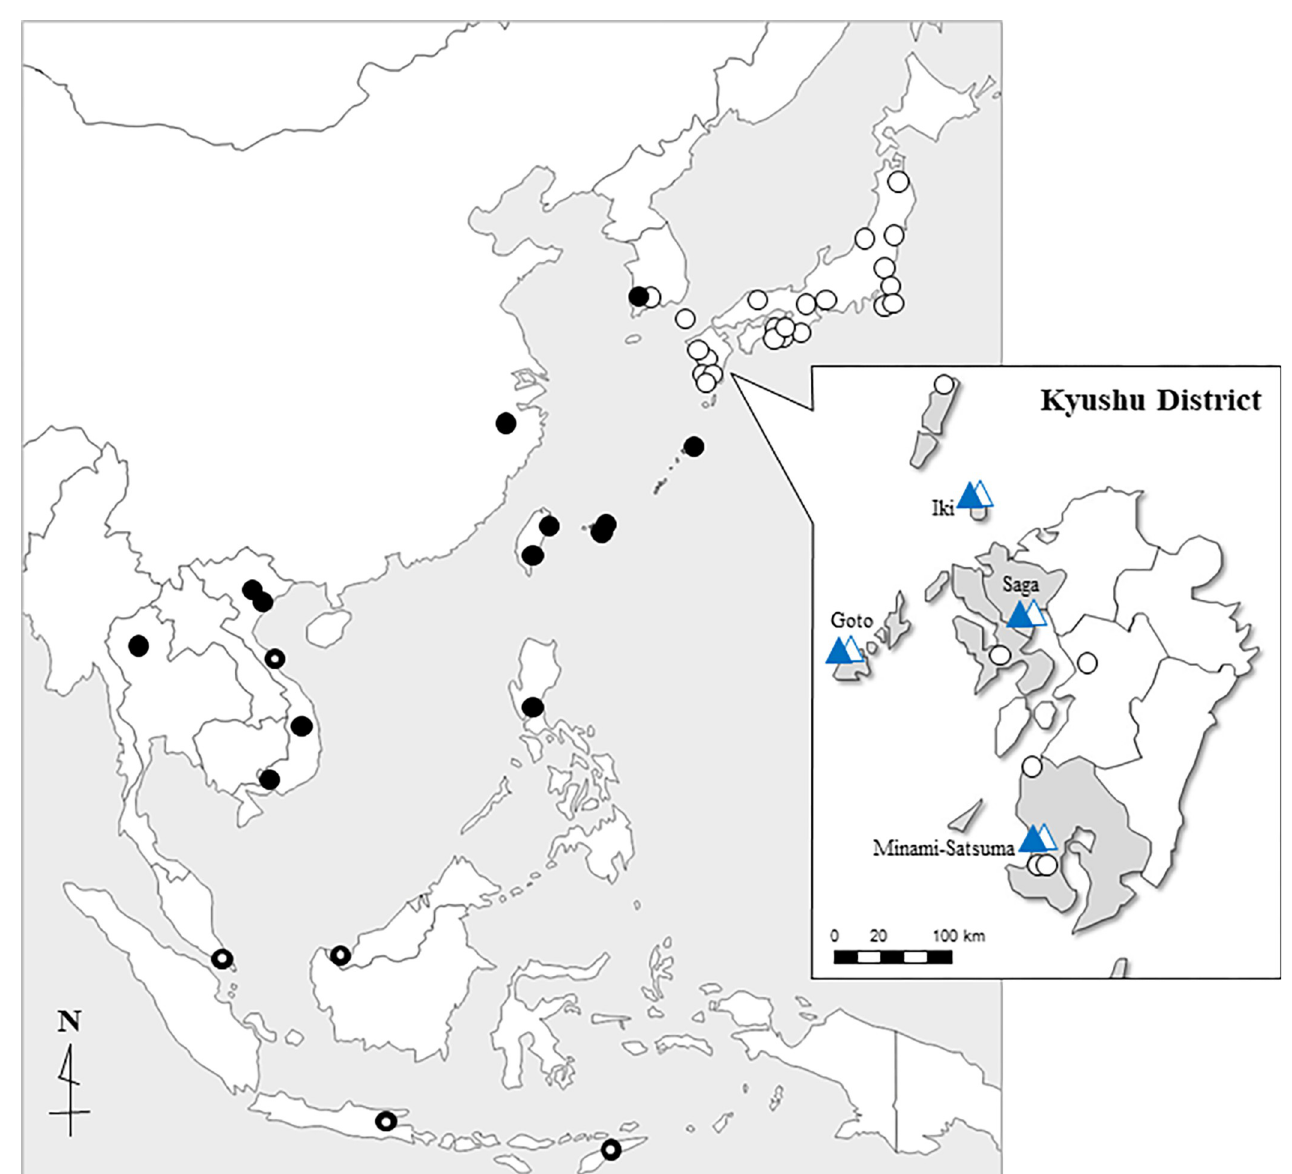
Fig 3. Locations of the mosquito collection sites in this study are shown here and details are given in S1 Table. The phylogenetic analysis indicated the Cx . tritaeniorhynchus was categorized into two taxa, Ct -J (open circles) and Ct -C (closed circles). The Cx . tritaeniorhynchus were captured in net-traps (NTs) and a Johnson-Taylor suction trap (JT-ST) installed at four localities on the Kyushu District (shaded area). Open and closed triangles with blue indicate capture of Ct -J and Ct -C of the Cx . tritaeniorhynchus , respectively. Double circles indicate specimens not used in the phylogenetic analysis, but are plotted on the map as the Ct -C referred from the COI sequences of the GenBank database. A map was created using free materials downloaded from the following websites: https:// power-point-design.com/ppt-design/world-map-for-powerpoint/ and https://power-point-design.com/ppt-design/japan-map-available-for-powerpoint/. Based on the geographical positions recorded using a geographical positioning system (GPS: GPSMAP64, Garmin, USA) (S1 Table), the collection sites were plotted on this